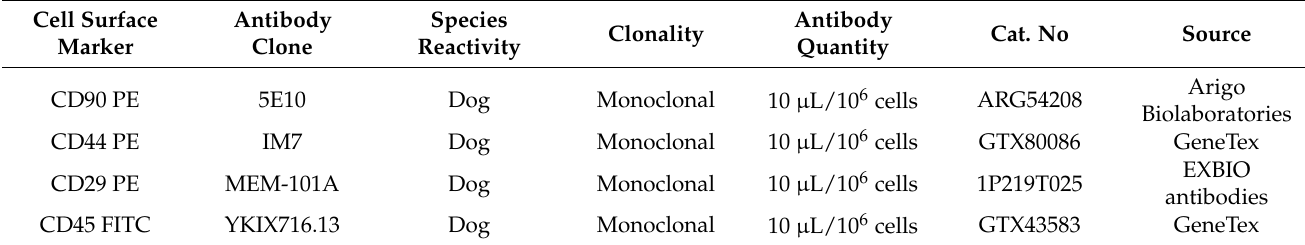
Table 1. The list of antibodies used for flow